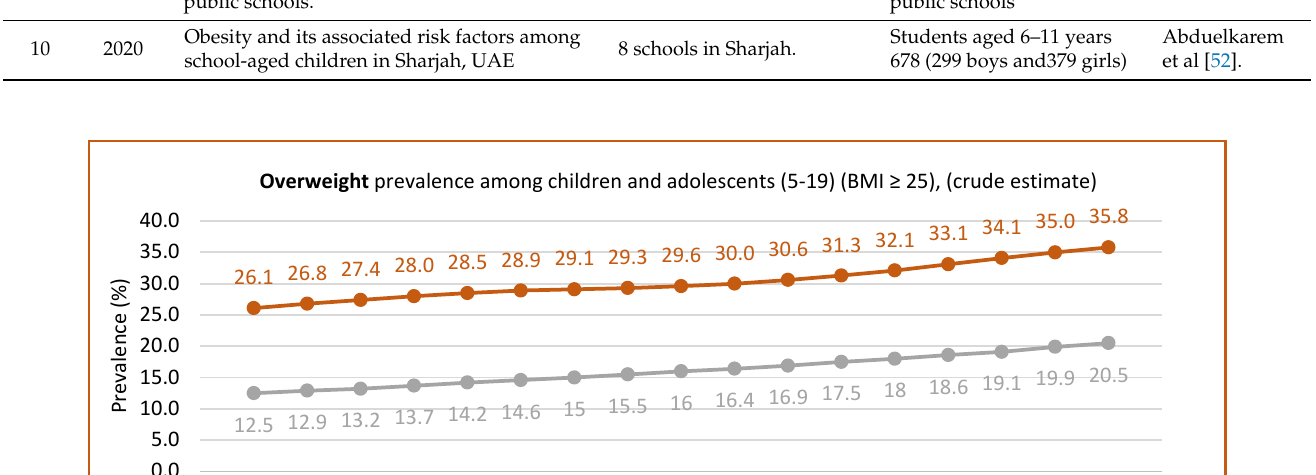
Figure 3. Overweight prevalence in children and adolescents (aged 5 – 19 years) (BMI ≥ 25) (crude estimate). Source: https://www.who.int/data/gho/data, http://www.healthdata.org/results/country-profile (accessed on 5 December 2022) [33,35]. Obesity prevalence among children and adolescents (5- 19) (BMI ≥ 30 ), (crude estimate)